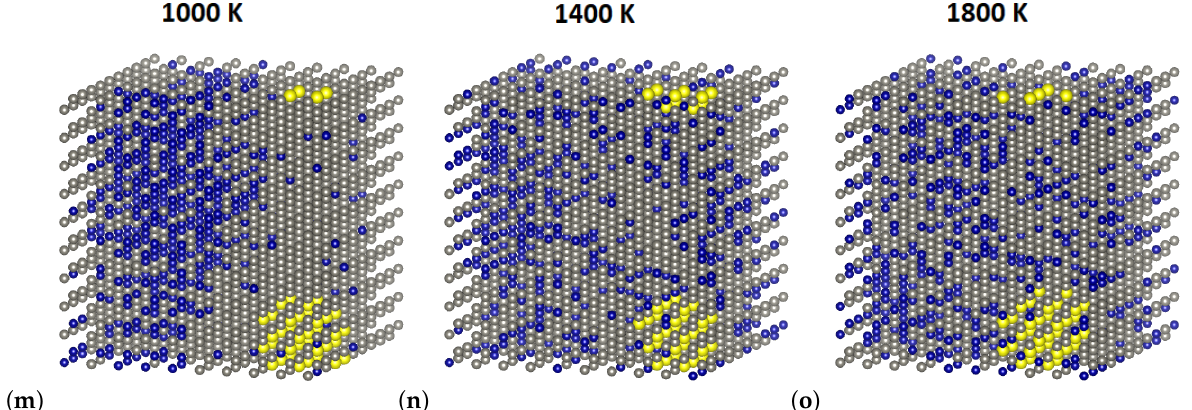
Figure 7. Structure images obtained from MC for ( a – c ) W 70 Cr 30 , ( d – f ) W 70 Cr 29.5 Y 0.5 , ( g – i ) W 70 Cr 29 Y 1 , ( j – l ) W 70 Cr 28.5 Y 1.5 , ( m – o ) W 70 Cr 28 Y 2 alloys at 1000 K ( left column), 1400 K ( middle column) and 1800 K ( right column).